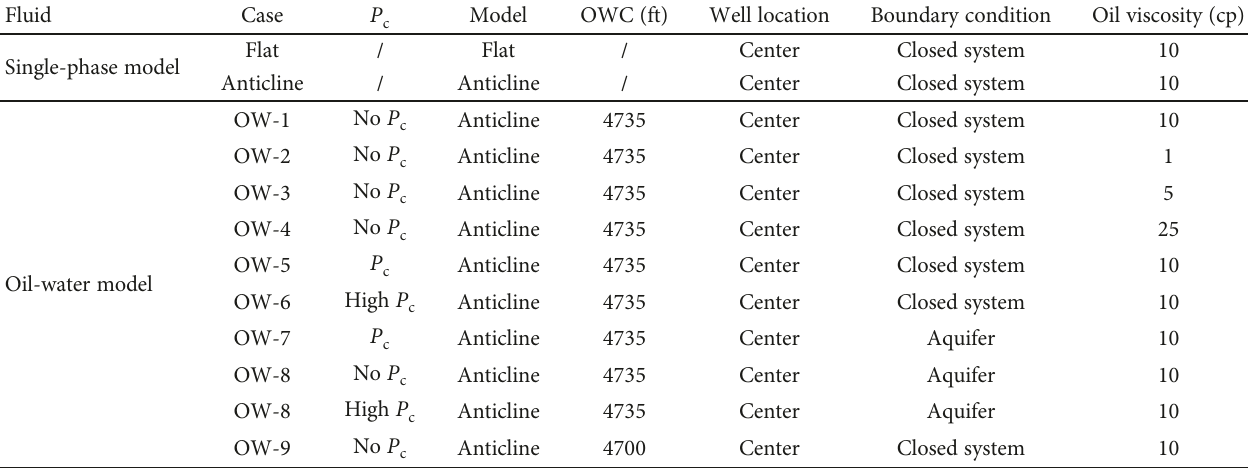
Table 2: The designs of di ff erent fl ow conditions.